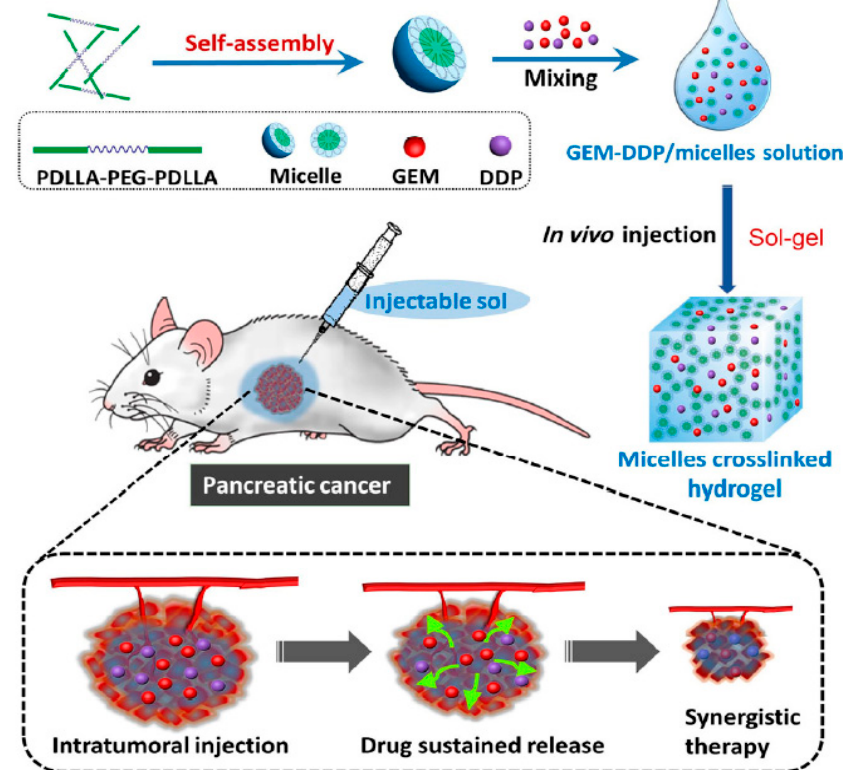
Figure 3. Schematic illustration demonstrating the mechanism of action of GEM/DDP-loaded thermal sensitive hydrogel. In water, the amphiphilic triblock copolymer (PDLLAPEG-PDLLA) underwent self-assembling into micelles at room temperature. GEM and DDP were dissolved into a predetermined amount of micelles solution to form a homogeneous (GEM-DDP/micelles) mixture. Upon exposure to body temperature, the resulting mixture spontaneously gelated into a cross-link hydrogel network (GEM-DDP/hydrogel). Following intra-tumoral injection, (GEM-DDP/hydrogel) dispersed around tumour sites, producing the sustained release of GEM and DPP, facilitating their synergic antitumour activity. Reprinted with permission from Shi et al. [91]. 2022, Springer Nature.